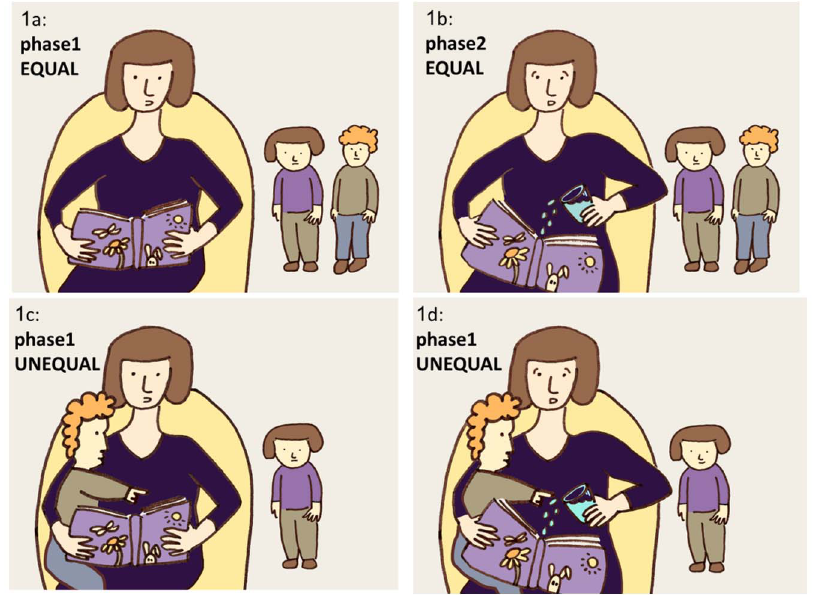
Figure 1. The EQUAL and the UNEQUAL conditions. In the EQUAL condition the mother reads a book aloud to herself while the kids are playing (Figure 1a) the mother is then signaled to take the glass of water and accidently spill water over the book (Figure 1b). In the UNEQUAL condition the mother placed the peer on her lap and embraced the child while reading a story aloud to that child (Figure 1c) and then she was signaled to accidently spill water on the book (Figure 1d). At both conditions the child were allowed to play freely.